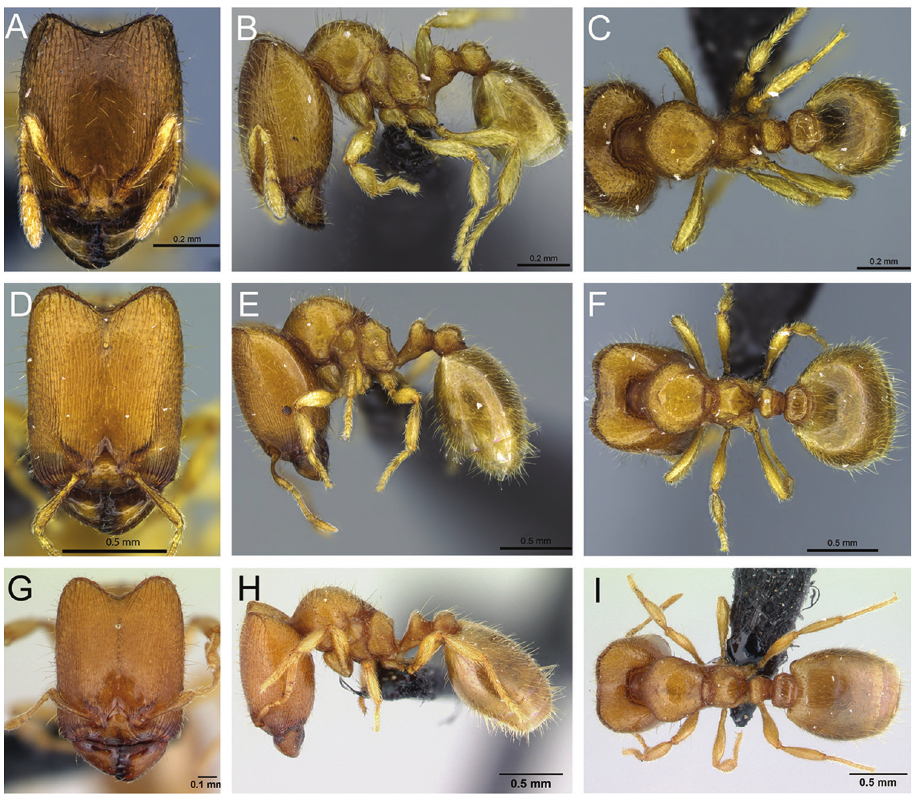
Figure 67. Intermediates of Carebara vazimba . Major workers, CASENT0055650: A head in full-face view B body in profile view C body in dorsal view. CASENT0055532: D head in full-face view E body in profile view F body in dorsal view. CASENT0110667 G head in full-face view H body in profile view I body in dorsal